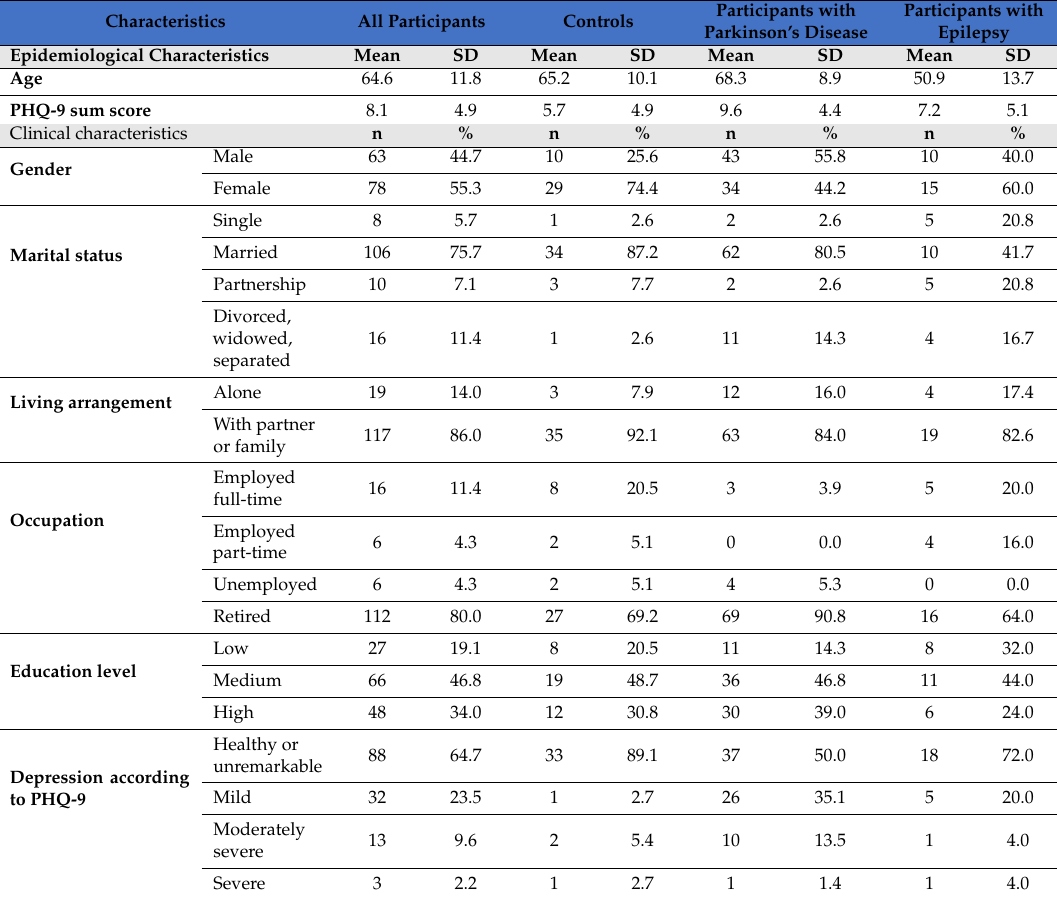
Table 1. Epidemiological and clinical characteristics of the cohort.